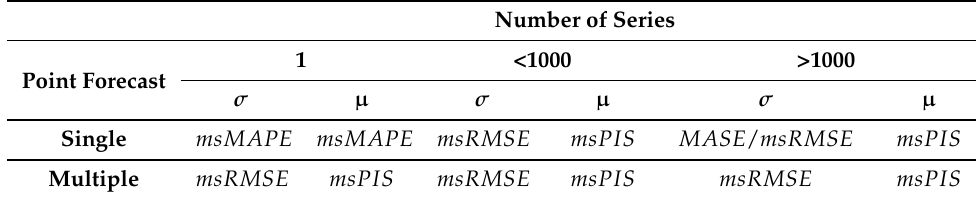
Table 5. Best choice of metric for different cases based on the reliability